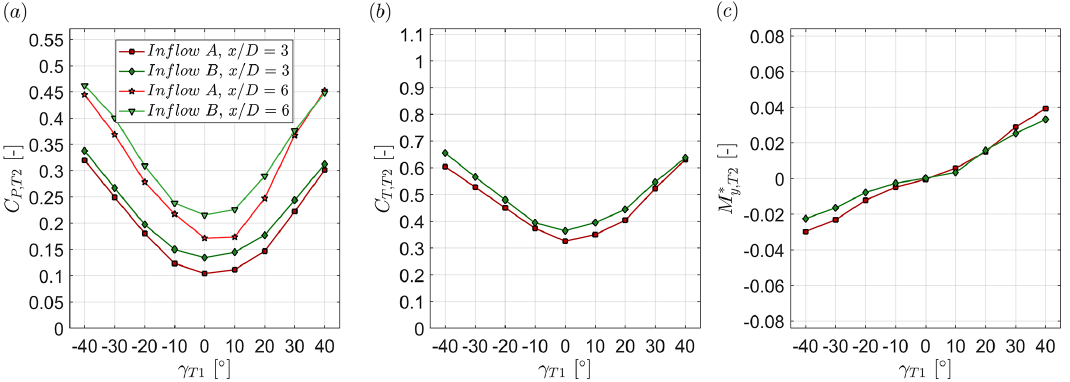
Figure 4. Downstream turbine (a) power coefficient, (b) thrust coefficient and (c) normalized yaw moment as a function of the upstream turbine’s yaw angle γ T1 . The downstream turbine T2 is located at x/D = 3 and x/D = 6. The turbines are exposed to inflows A and B.